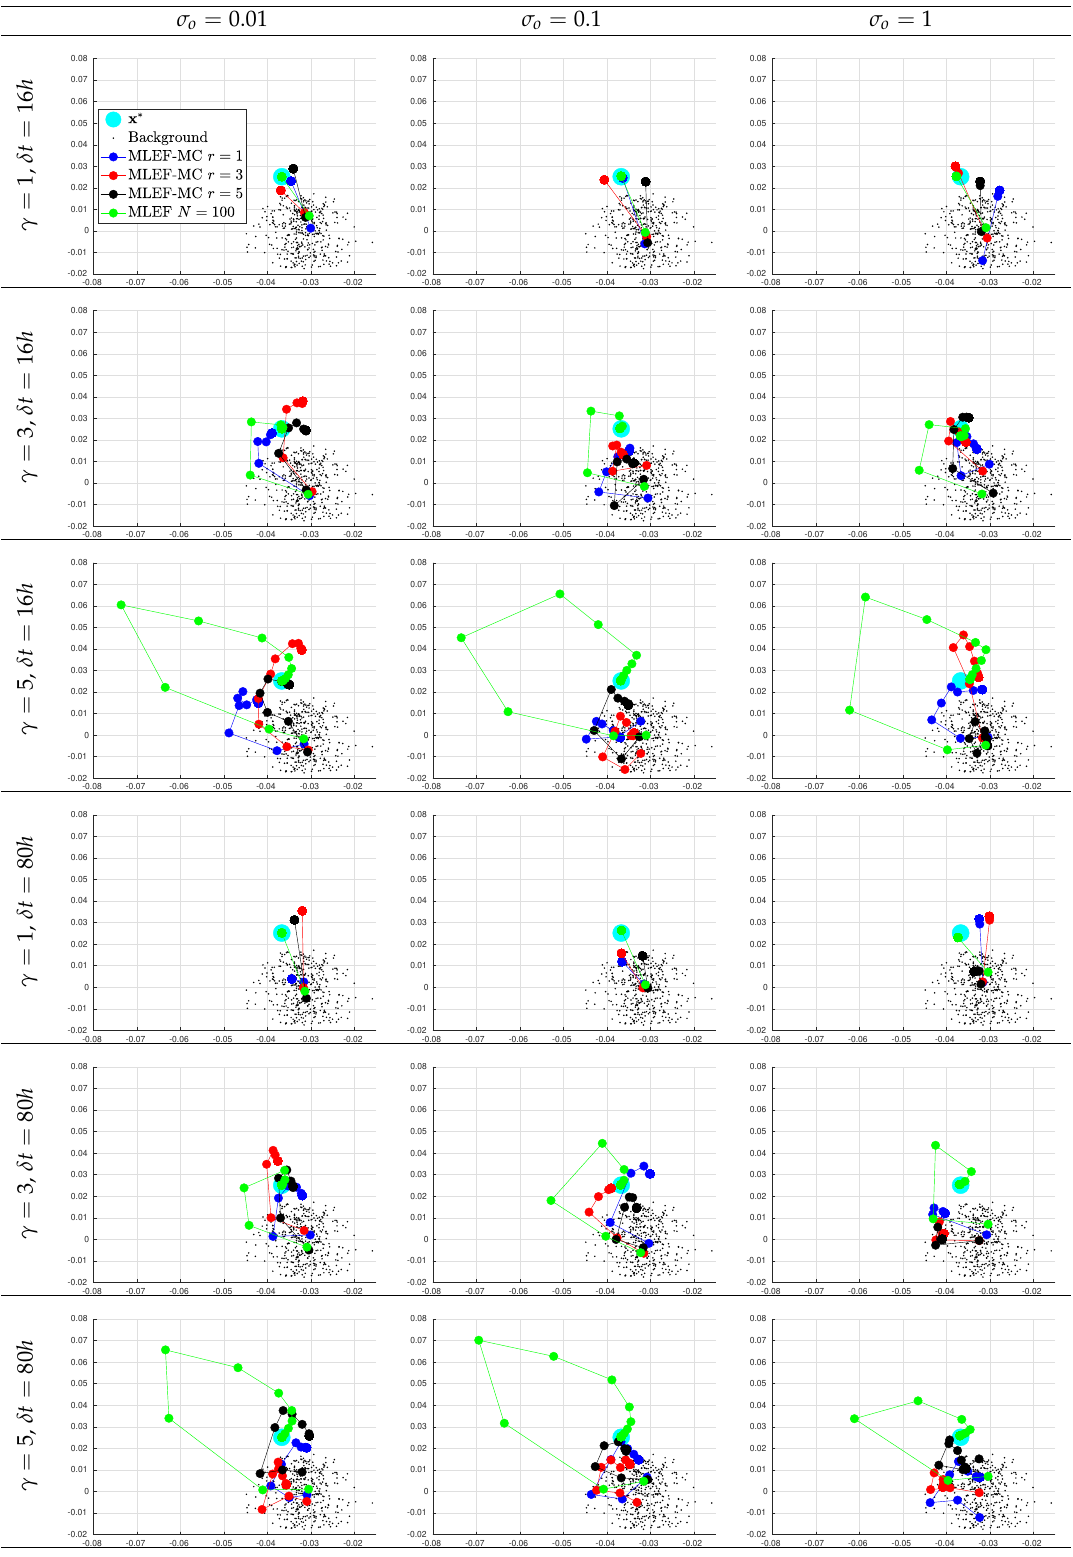
Figure 8. Snapshots of iterates for the initial analysis step. Different time frequencies of observations were employed during the experiments. The percentage of observations from the model state reads s =